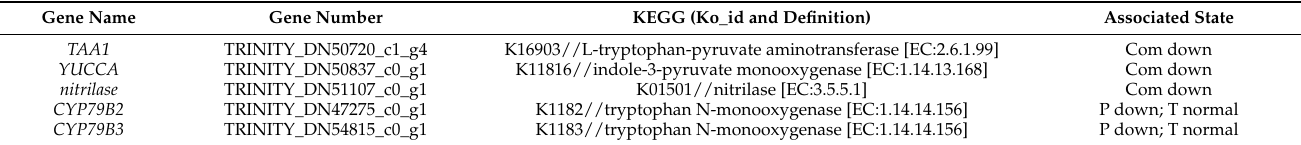
Table 5. Relationship between differentially expressed proteins of tryptophan metabolic pathway and their corresponding